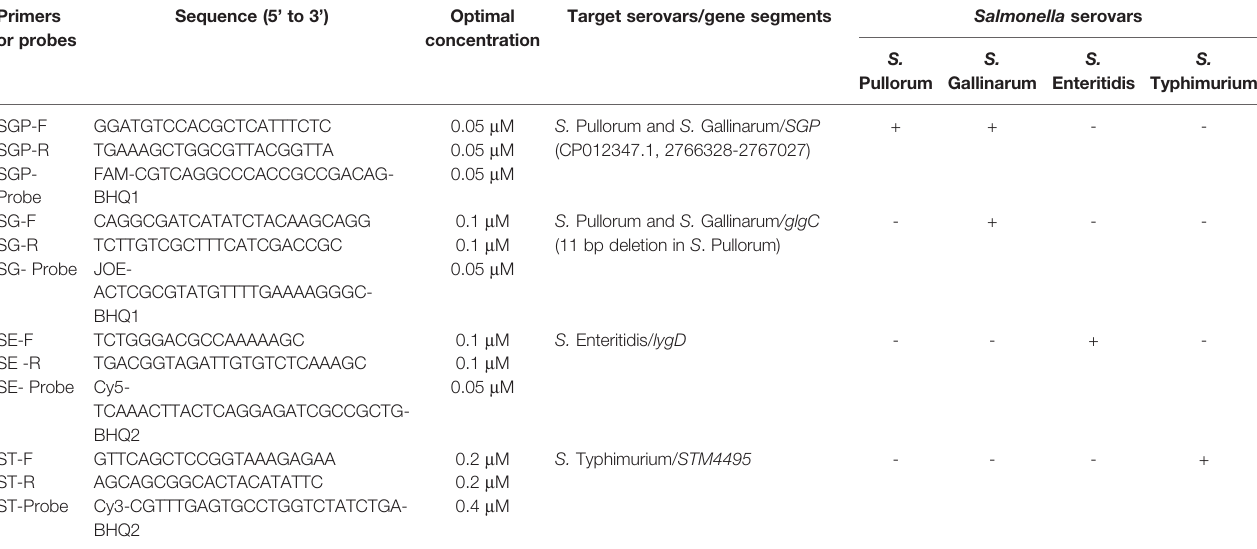
TABLE 2 | Primers and probes used for the multiplex real-time PCR.